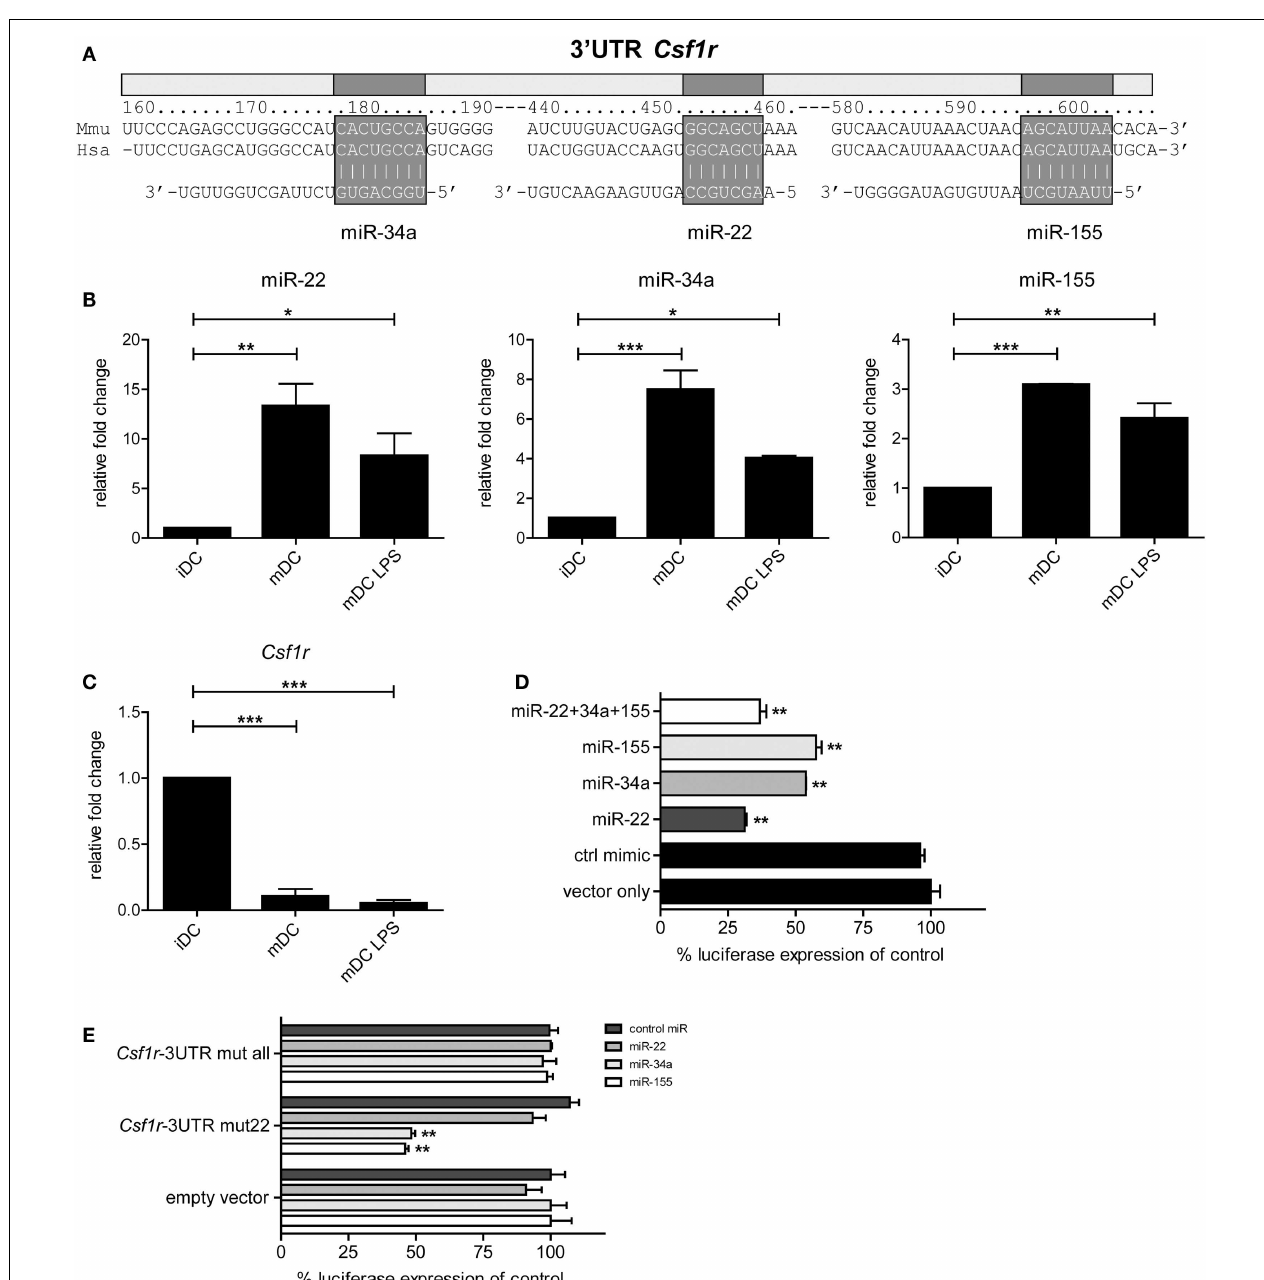
containing (D) the wild-type mouse Csf1r -3 (cid:48) UTR or (E) a mutant Csf1r -3 (cid:48) UTR harboring three nucleotide point mutations in each seed region of the corresponding miR-22, -34a, and miR-155 binding sites ( Csf1r -3 (cid:48) UTR mut all), or in the miR-22 site only ( Csf1r -3 (cid:48) UTR mut22).The original psiCHECK-2 vector (containing no 3 (cid:48) UTR insert) was used as a control (empty vector). Cells were co-transfected with the hairpin precursors of miR-22, miR-34a, miR-155, or control oligonucleotide, all at a final concentration of 50nM. A ubiquitously expressed firefly luciferase gene, also encoded by the vector, was used to normalize transfection efficiency. Luciferase activity was measured 48h after transfection. Data are expressed as means ± SEM from three